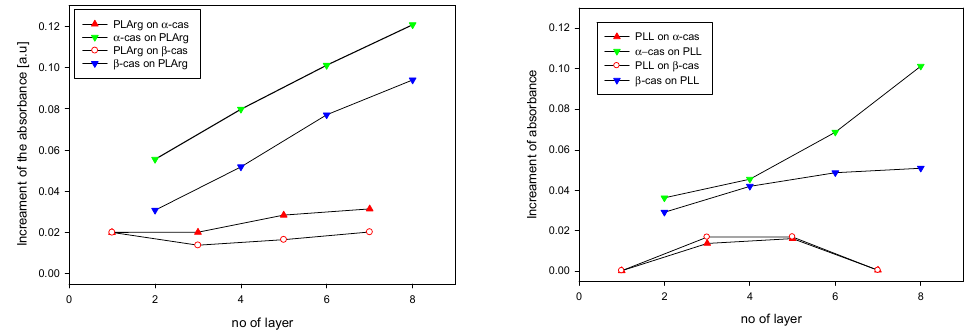
Figure 7. The amid I absorption increments after deposition of the consecutive polypeptide or casein layer during multilayer film formation.